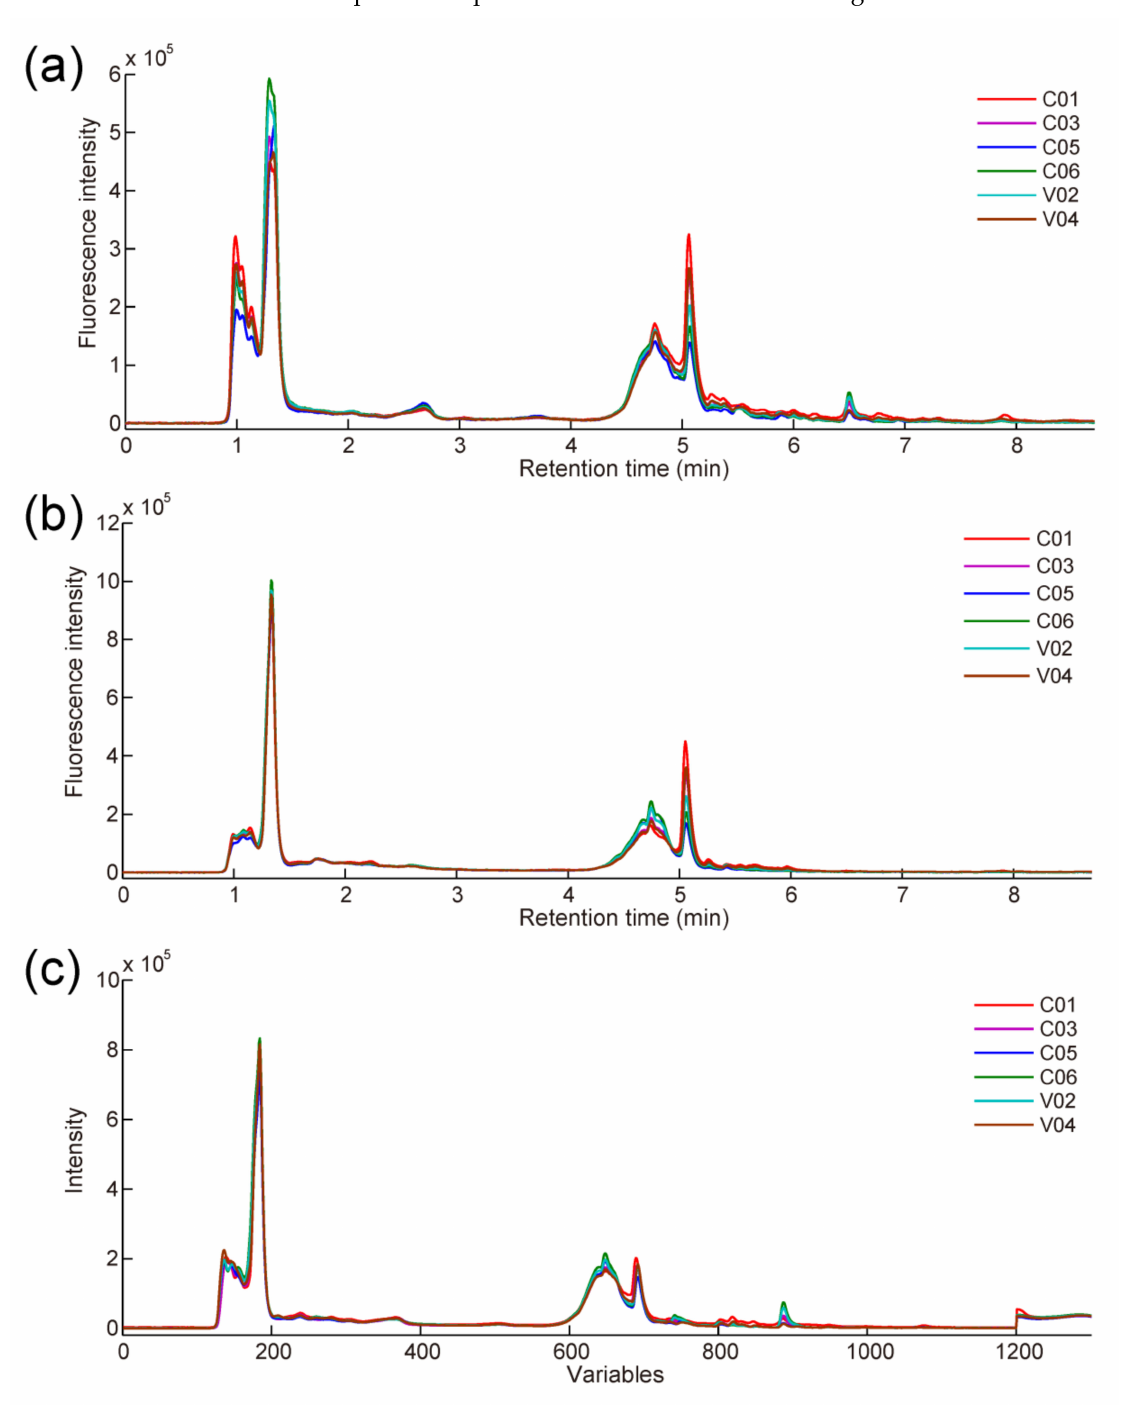
Figure 2. First-order fingerprint signals of selected samples from case 6 (Guizhou WZ adulterated with Guizhou PD) collected at 380 nm ( a ) and 440 nm ( b ), respectively; first-order fusion fingerprint signals of selected samples from case 4 (Guizhou XM adulterated with Henan NH) generated by DVF ( c